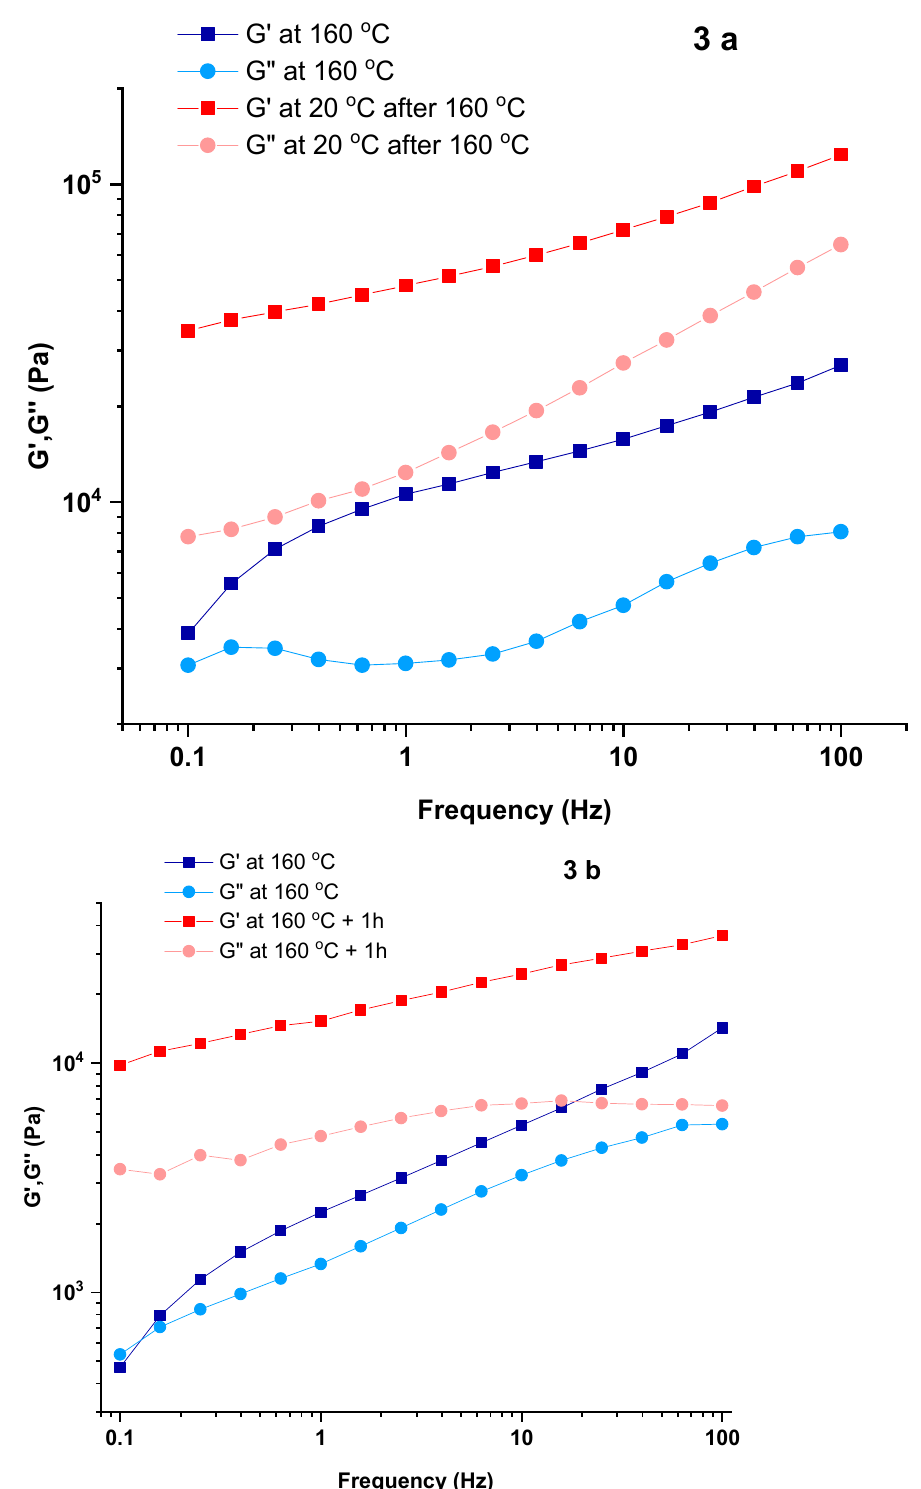
Figure 19. Frequency dependences of G ′ , and G ″ for polymers 3 a ( top ) at 160 °C and after cooling to 20 °C, and for polymer 3 b ( bottom ) at 160 °C and after heating at 160 °C for 1h.